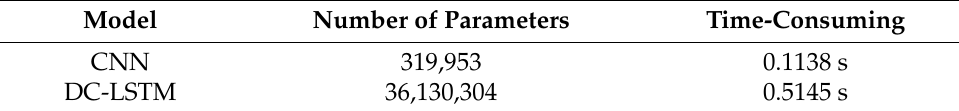
Table 6. Comparison of computation power required by different models.